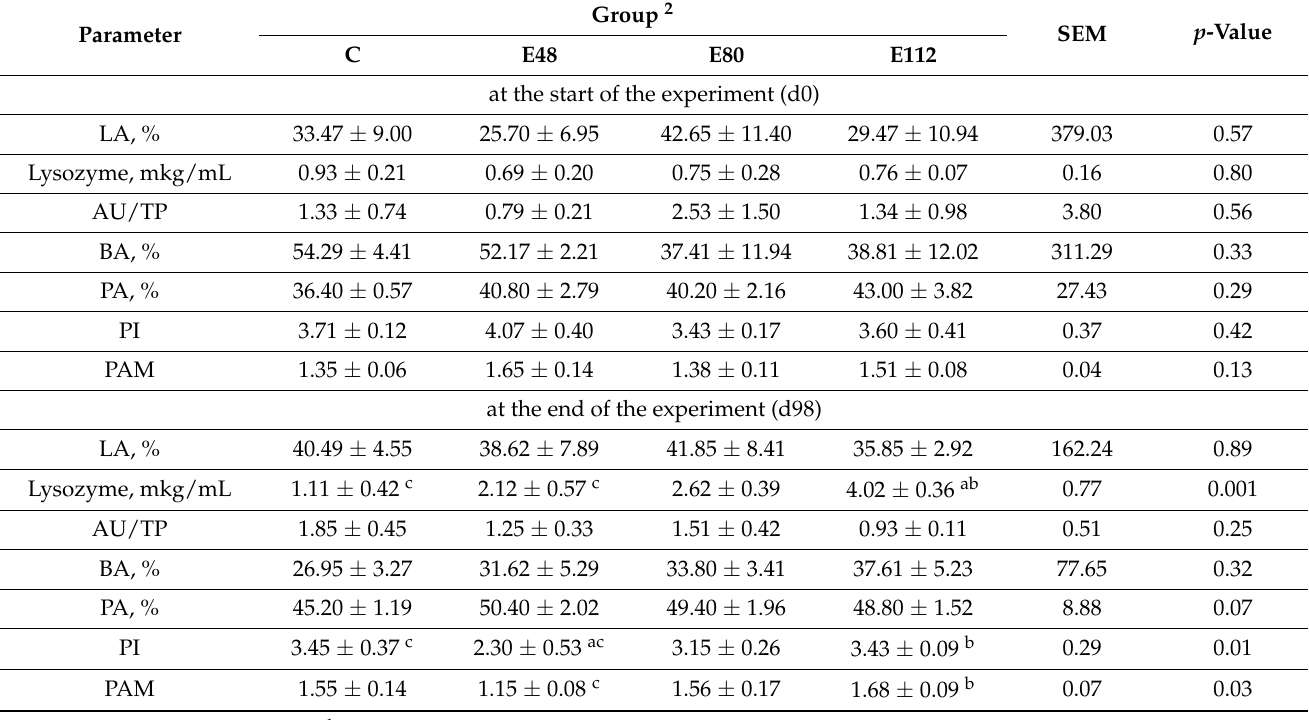
Table 4. Indicators of nonspecific resistance of experimental animals 1